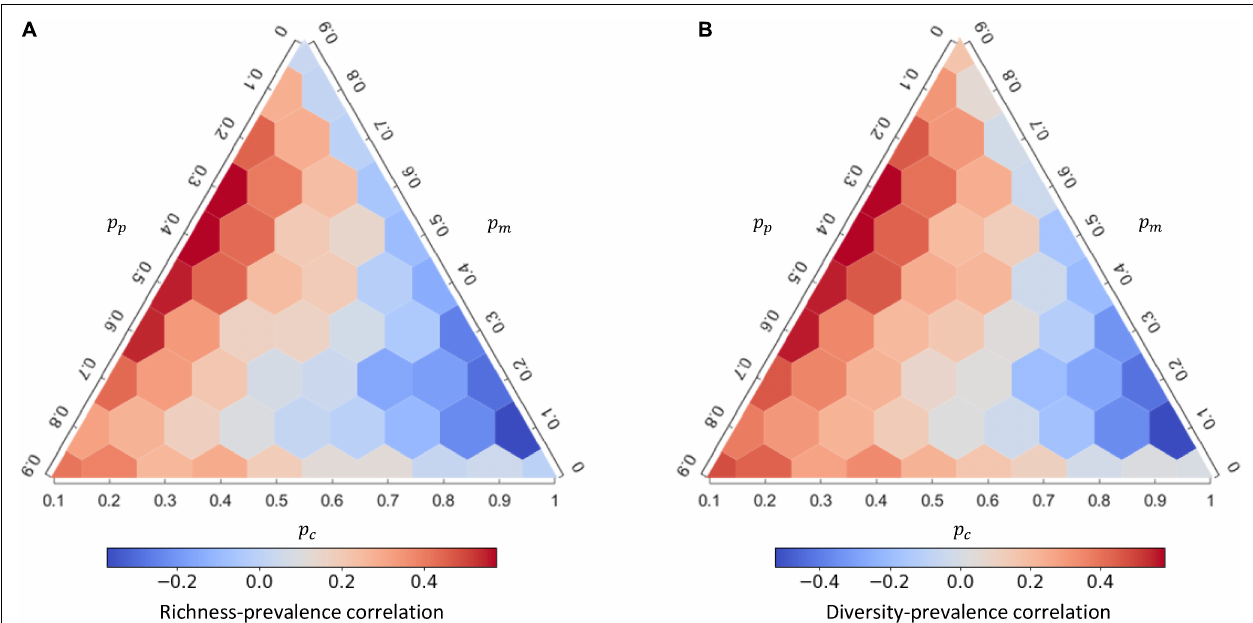
FIGURE 4 | The response of richness-prevalence correlation and diversity-prevalence correlation to interaction composition under density-dependent (DD) disease transmission. Richness-prevalence correlation (A) and diversity-prevalence correlation (B) of the response for each interaction composition, calculated from 1,000 replicates. See Supplementary Figure 8 for the corresponding figure under frequency-dependent (FD)